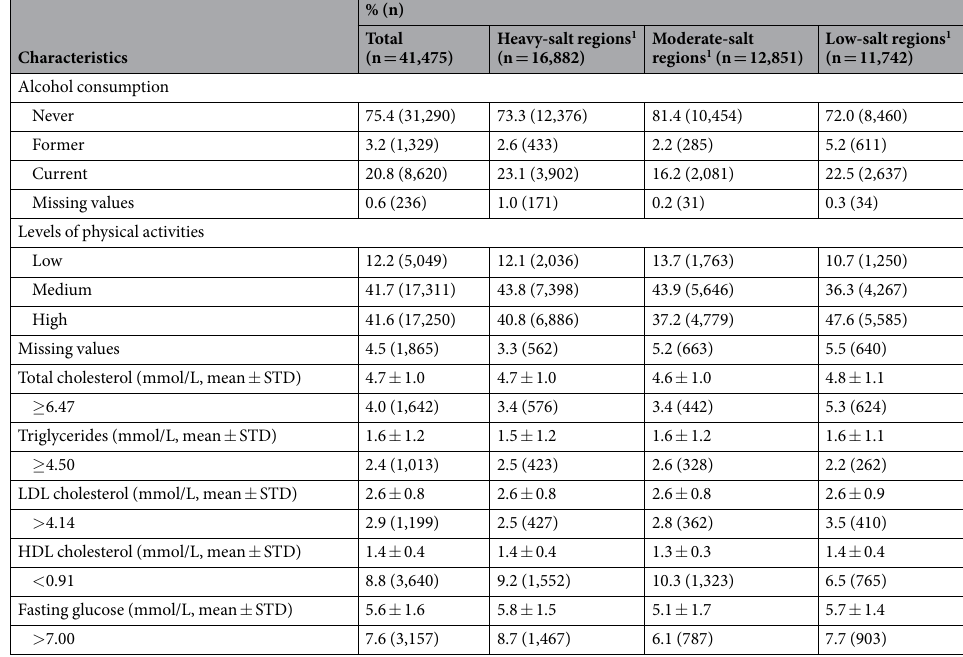
Table 1. Characteristics of the eligible participants in the Sodium and Potassium Study from PURE-China Cohort. Note: STD, standard deviance; LDL, low-density lipoprotein; HDL, high-density lipoprotein; 1 Per National Diet Salt Intake in 2002 28 , PURE-China centers were classified three salt-diet regions: heavy-salt regions ( > 8 grams of daily salt intake) included Beijing, Jiangsu Province, Jiangxi Province, and Liaoning Province; moderate-salt regions (7 to 8 grams) included Qinghai Province, Shaanxi Province, and Shandong Province; low-salt regions ( < 7 grams) included Inner Mongolia, Sichuan Province, and Yunnan Province, Shanxi Province, and Xinjiang Province. 2 Estimated excretion was calculated by a fasting morning urine specimen on the basis of the Kawasaki formula 18 ; 3 Creatinine excretions were determined according to a formula including age, sex, weight, and height, which also was used in Kawasaki formula to estimate sodium and potassium excretion.